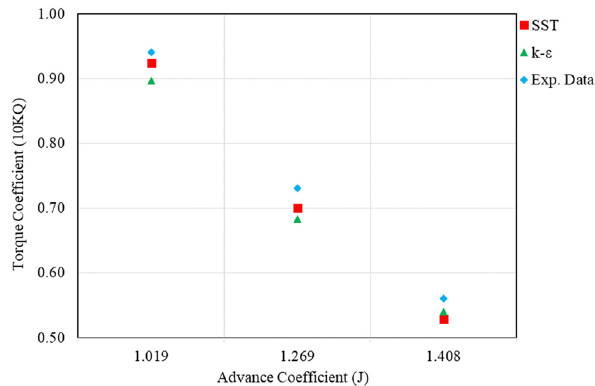
Figure 14: Numerical results of thrust coe ffi cient K T ( ) of the Kunz cavitation model.